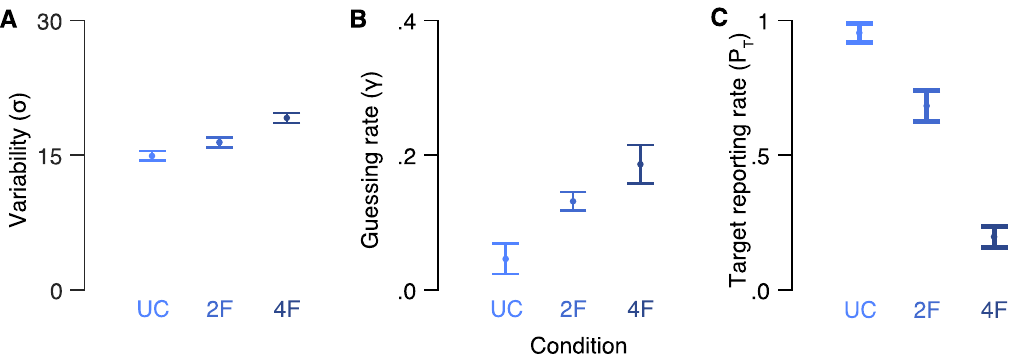
Figure 6. Model parameters in “Experiment 2”. ( A ) Mean standard deviation (σ), ( B ) guessing rate (γ) and ( C ) target reporting rate (P T ) for each crowding condition. Model parameters are of the S, M2 and M4 models in the uncrowded, two-flanker and four-flanker conditions, respectively. UC uncrowded, 2F two-flanker and 4F four- flanker. Error bars are ± 1